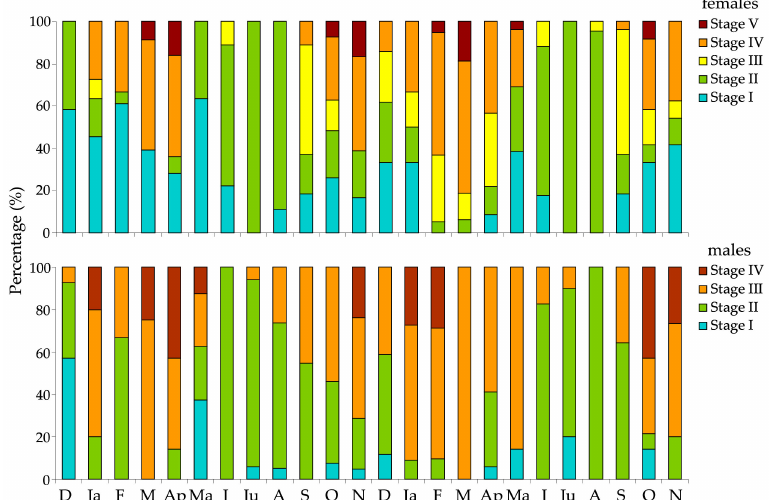
Figure 5. Relative frequency of gonad maturity stages of female and male Paracentrotus lividus individuals at the S1 station in the Pagasitikos Gulf, per month, from December 2008 to November